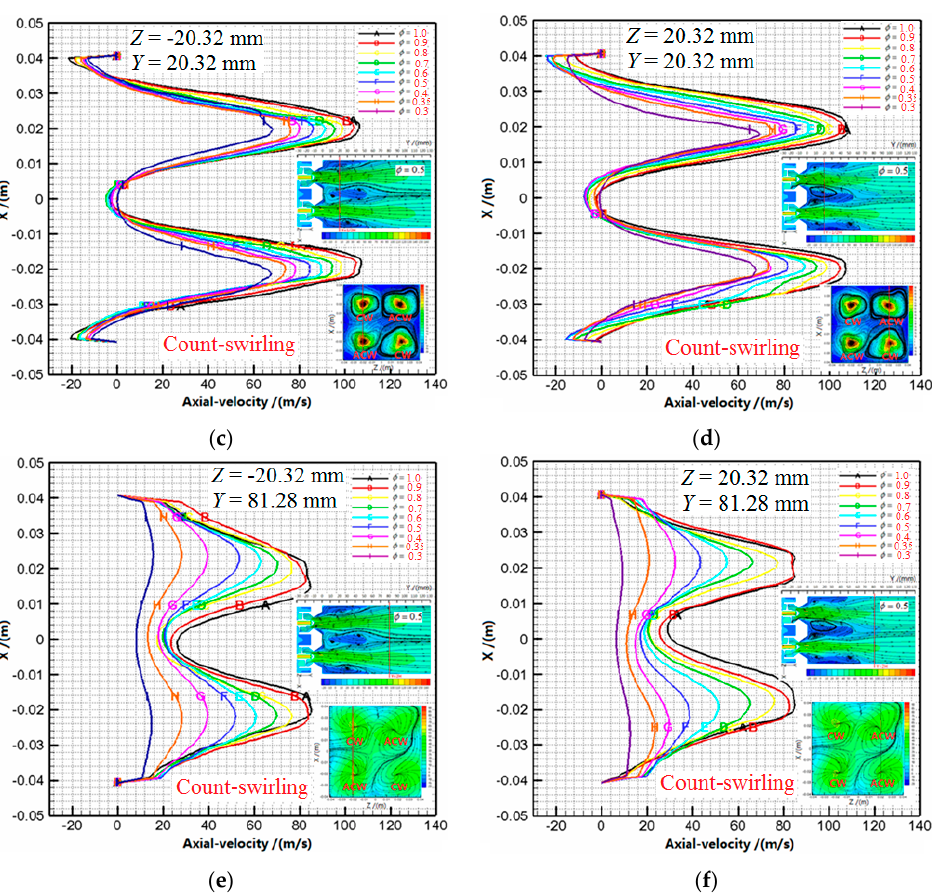
Figure 5. Axial velocity profiles and contours compared for count-swirling four-point LDI combustors with different equivalence ratios.